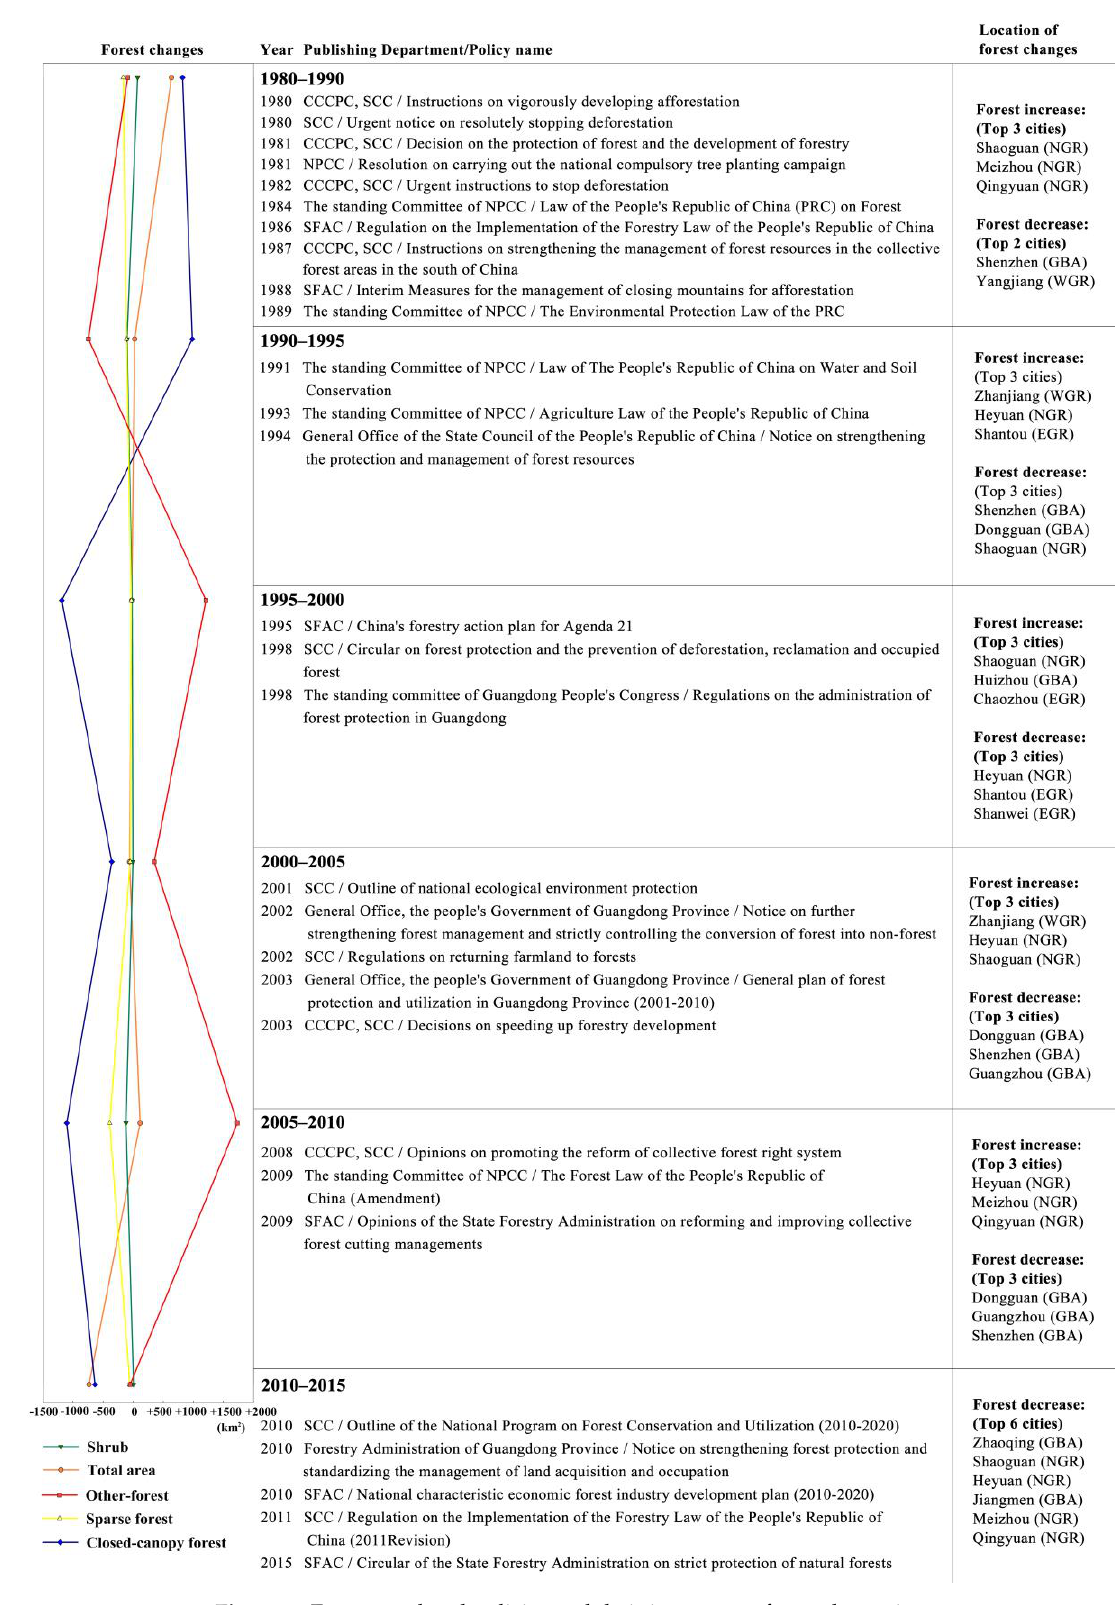
Figure 8. Forestry related policies and their impacts on forest dynamics. During 2010 – 2015, forest area coverage decreased by 734 km 2 . NGR region experi- enced the highest decline in which a total of 338 km 2 was lost, of which 236 km 2 was